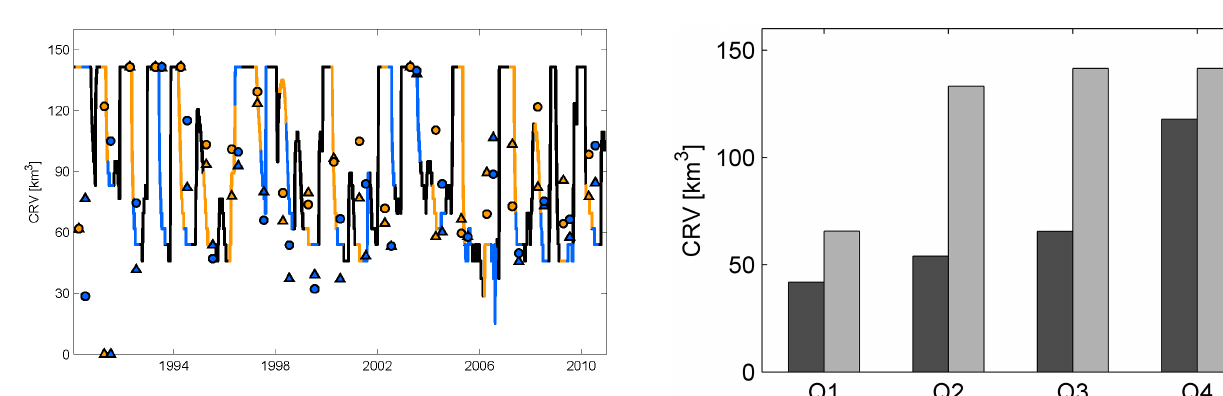
Figure 8. The modeled cod reproduction volume (CRV) (black line). The second and third quarter periods are highlighted by yel- low and blue, respectively. The second and third quarterly average cod reproduction volumes, calculated from BY4 and BY5 data, are represented by triangles and circles, respectively.